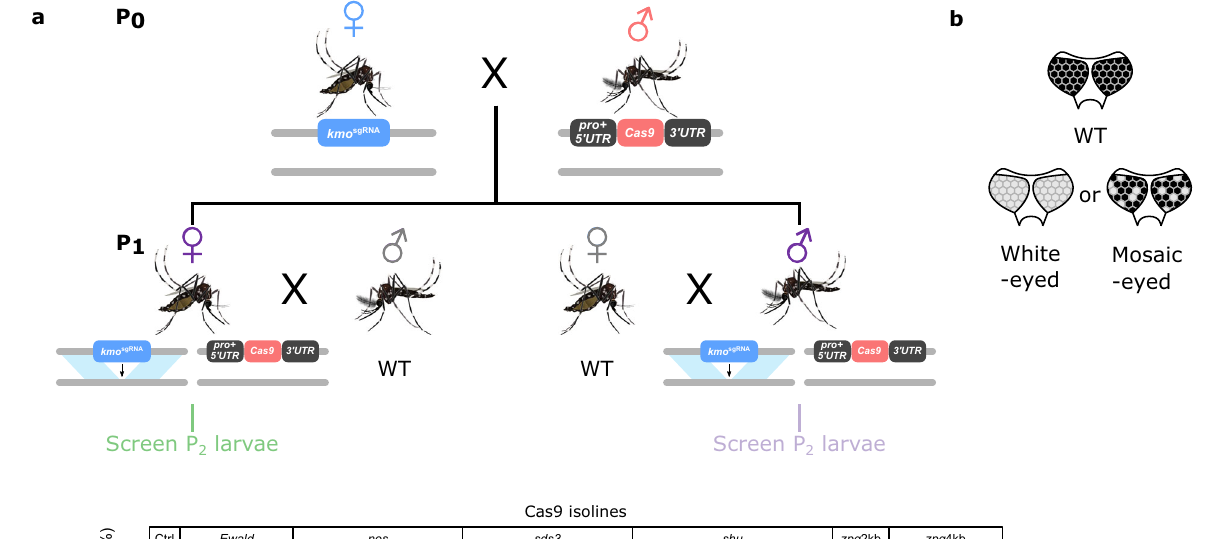
two-sided exact test relative to the control inheritance rates represented by the dotted line ( p ≥ 0.05 ns , p <0.05*, p <0.01**, and p <0.001***). d Percentage of P 2 larvae exhibiting WT or mosaic/white-eye phenotype, according to genotype. † The integration sites for Ewald C1-Cas9, Ewald C2-Cas9, and nos A2-Cas9, isolines are likely linked in trans to kmo sgRNAs indicated by the low representation of the trans- heterozygoteand non-transgenic genotypes in P 2 .Mosquito fi guresobtainedfrom Ramirez 38,39 . Source data are provided as a Source data fi le. pro=promoter, ♂ =male, ♀